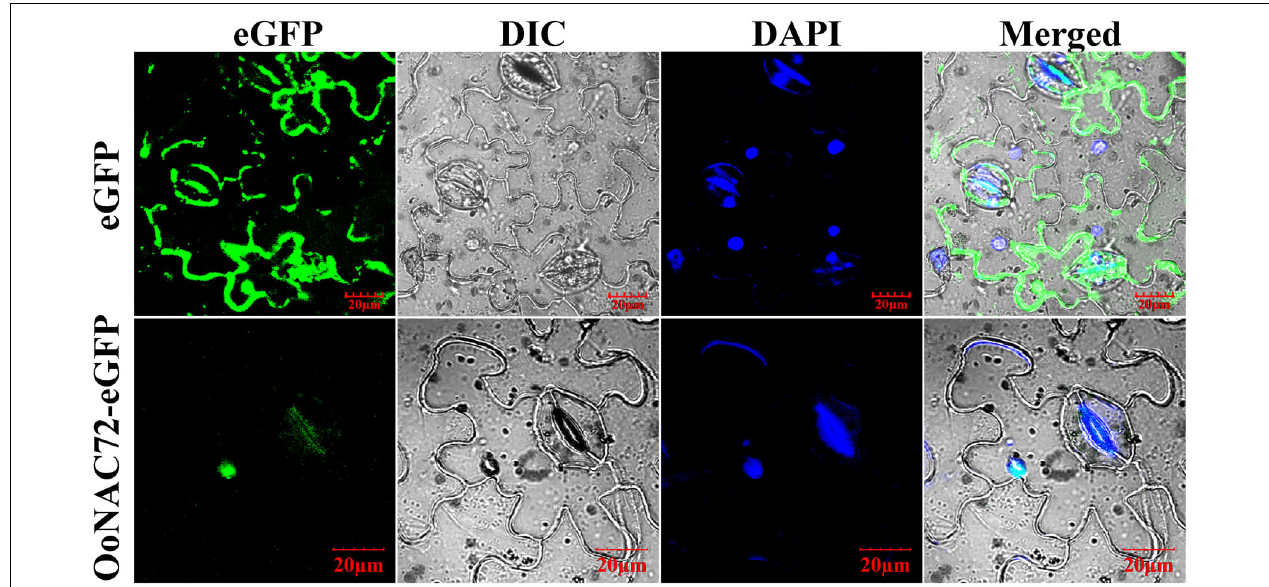
FIGURE 1 | Subcellular localization of the OoNAC72 protein in leaf epidermal cells of Nicotiana benthamiana . eGFP and OoNAC72-eGFP constructs were separately expressed instantly in leaf epidermal cells of Nicotiana benthamiana and observed under a laser scanning confocal microscope after agroinfiltration for 48 h. DAPI images indicate nuclear staining. eGFP images, DAPI stained images, differential interference contrast images (DIC) and merged images were taken. Bars = 20 µ m.